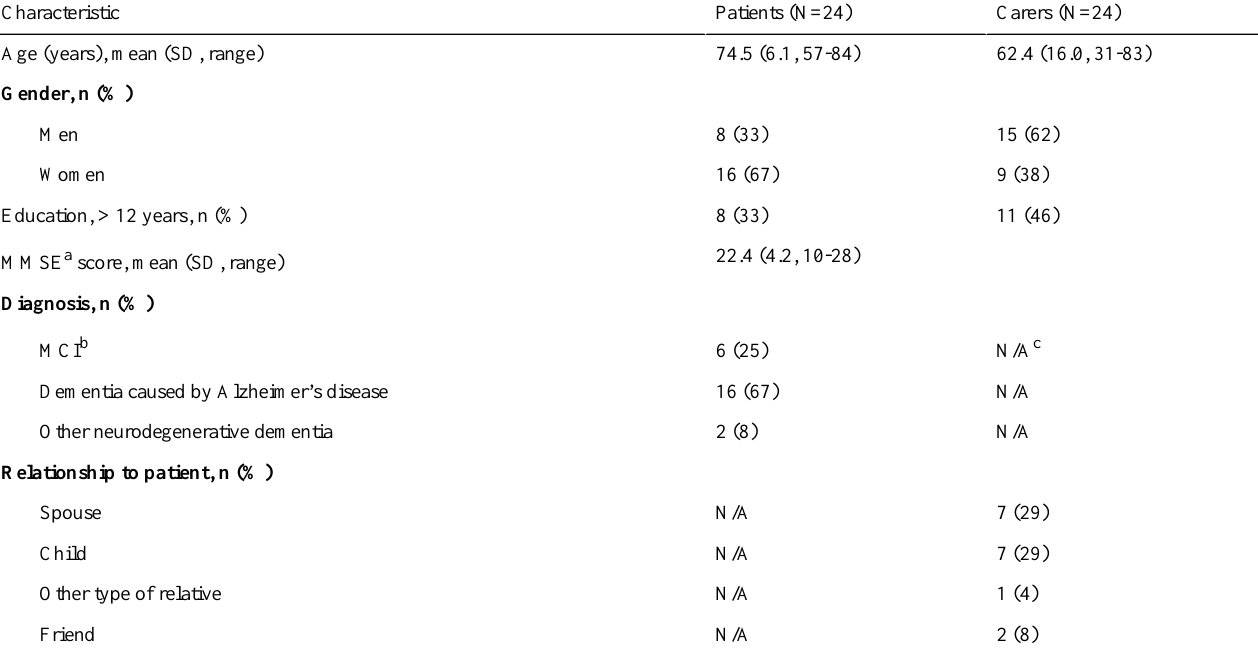
Table 1. Participant demographic data.